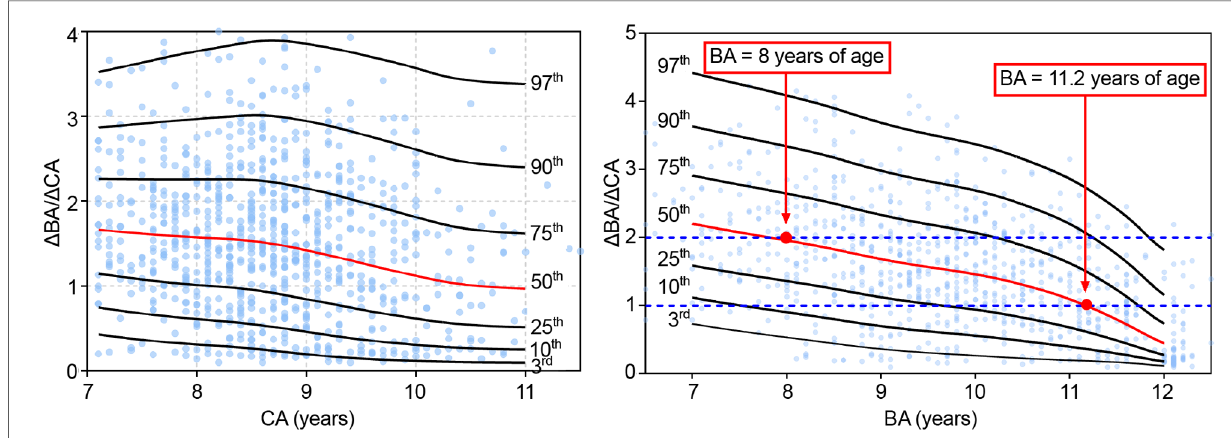
FIGURE 3 Δ ba/ Δ CA-for-CA/BA percentile curves for girls with EP. CA, chronological age; BA, bone age; EP, early-onset puberty.